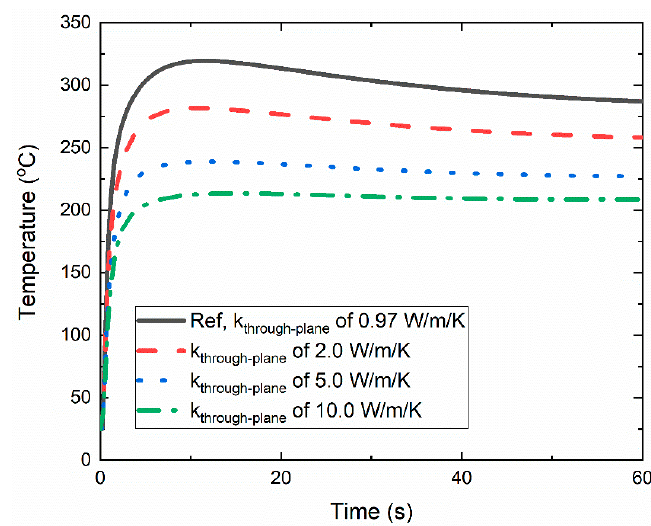
Figure 8. Modeling predicted maximum temperature on lithium-ion battery cell with di ff erent through-plane thermal conductivities.